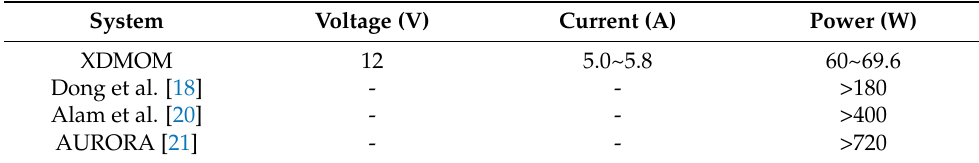
Table 8. Power consumption analysis of the novel system.